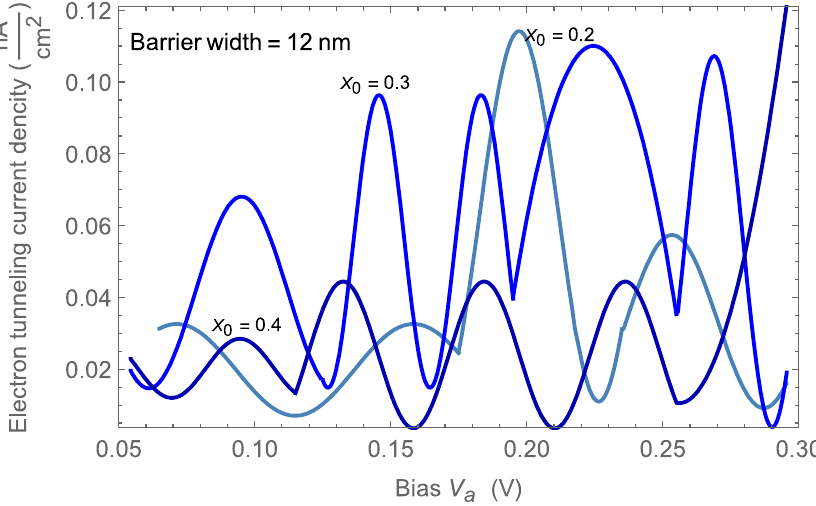
Figure 14. Current density-voltage characteristics of the electron tunneling at width barrier 12 nm.